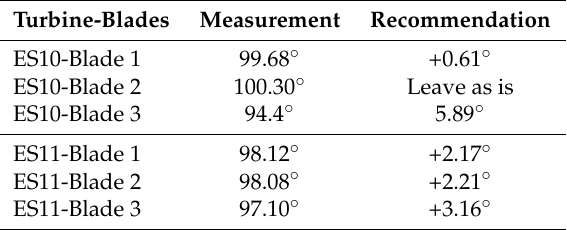
Table 2. Blade angle measurements and consequent